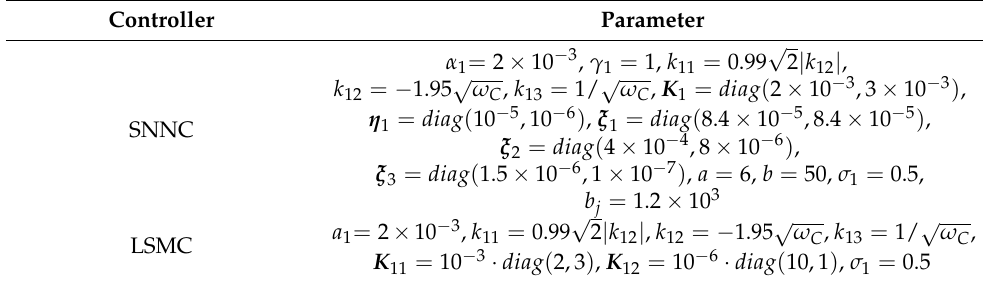
Table 2. Closed-loop controller parameters without radial